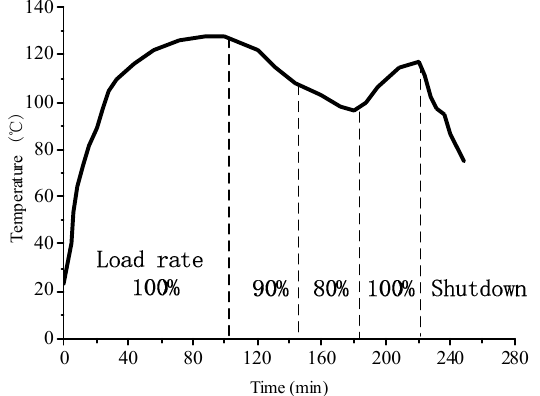
Figure 6. Temperature variation of an EM stator with load change.